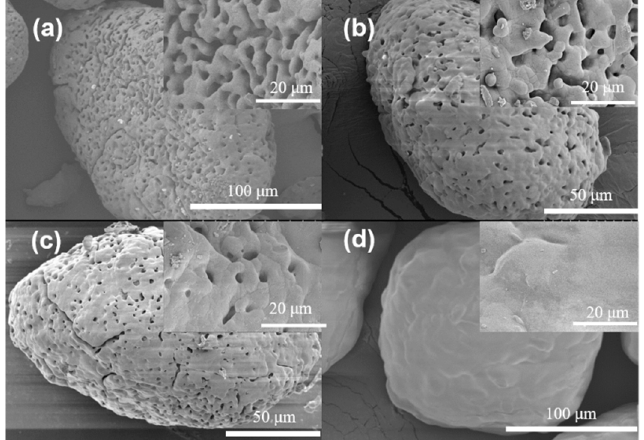
Figure 2. Scanning electron microscopy images of AP low-temperature decomposition residue. ( a ) AP with 29.9% mass loss; ( b ) AP with 20.2% mass loss; ( c ) AP with 9.5% mass loss; ( d ) initial AP without mass loss.